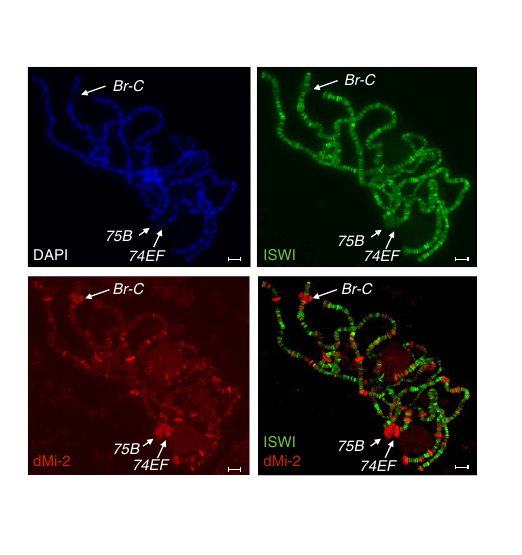
Gene GeneChromosomal